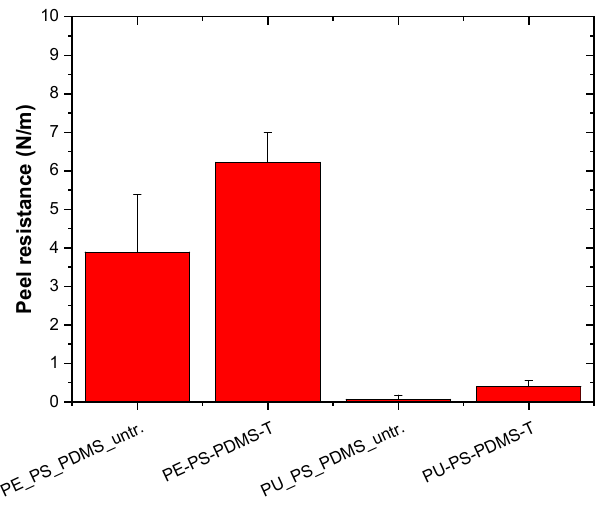
Figure 5. Peel resistance for PS/PDMS electrospun fiber mats of PE and PU.